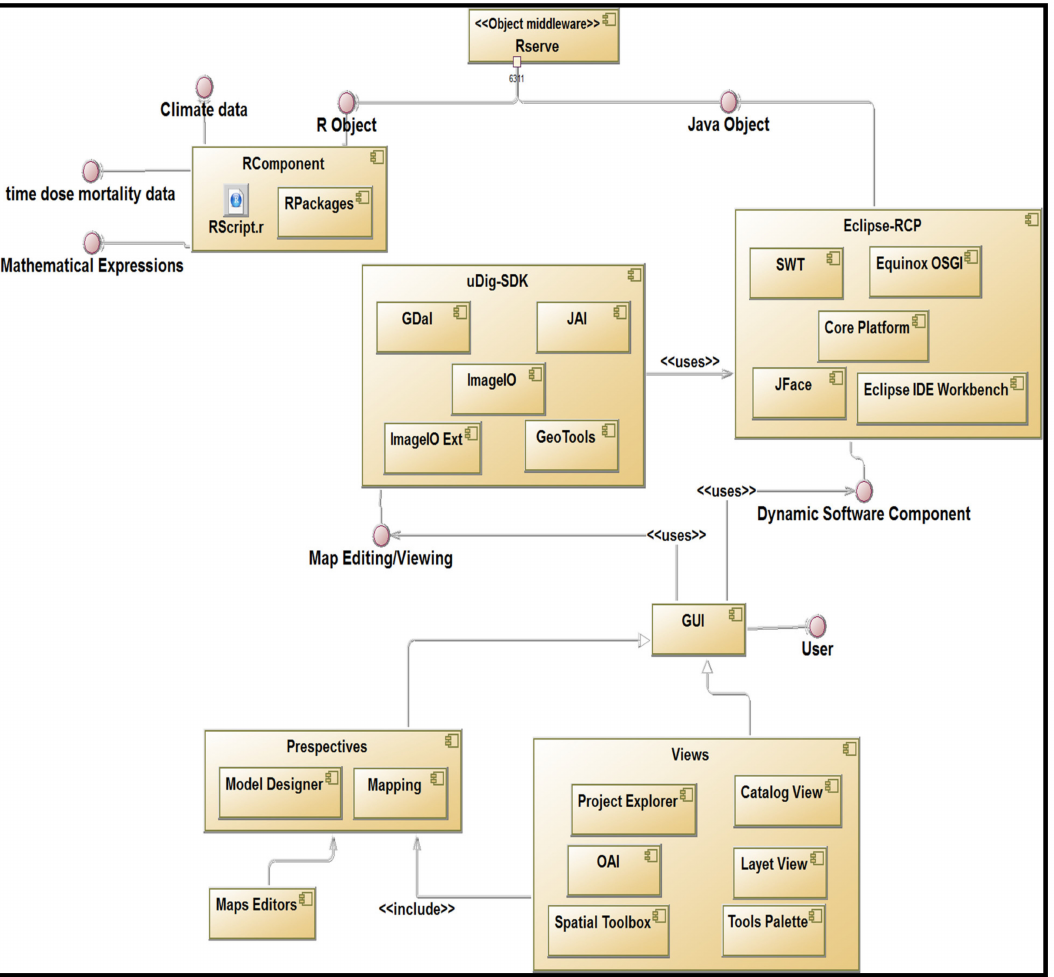
Figure 3. Unified modeling language (UML) component diagram. The users interact with the inbuilt software environment through the perspectives (model designer and mapping perspective) of the GUI. The GUI is based on the Eclipse-RCP (Rich Client Platform) and Udig-RCP components. Rserve